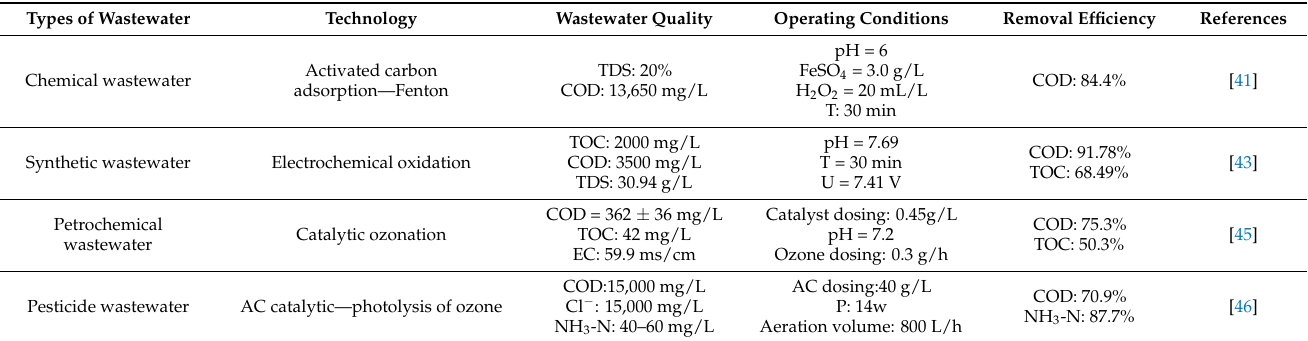
Table 3. Performance and experimental conditions of the advanced oxidation process for the treatment of saline